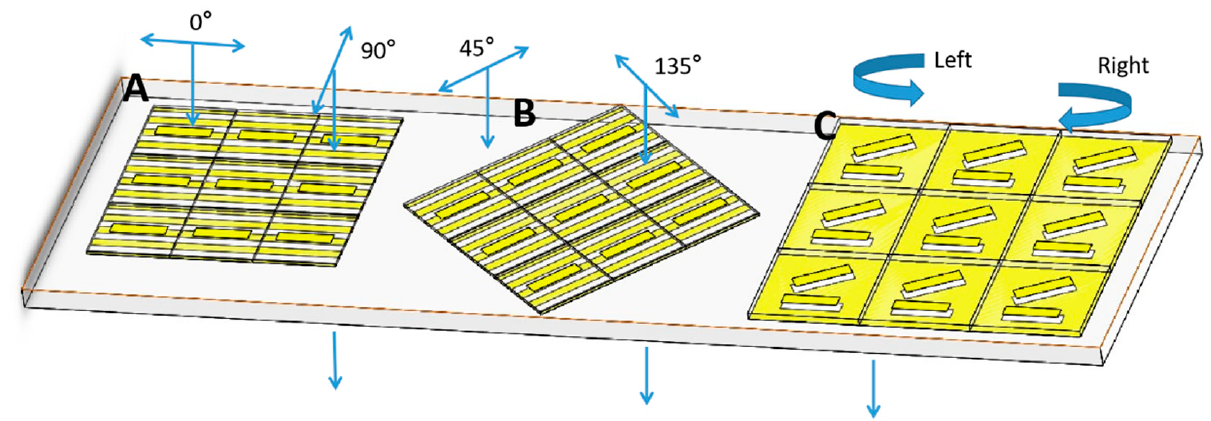
Figure 11. Full Stokes parameter detection structure.